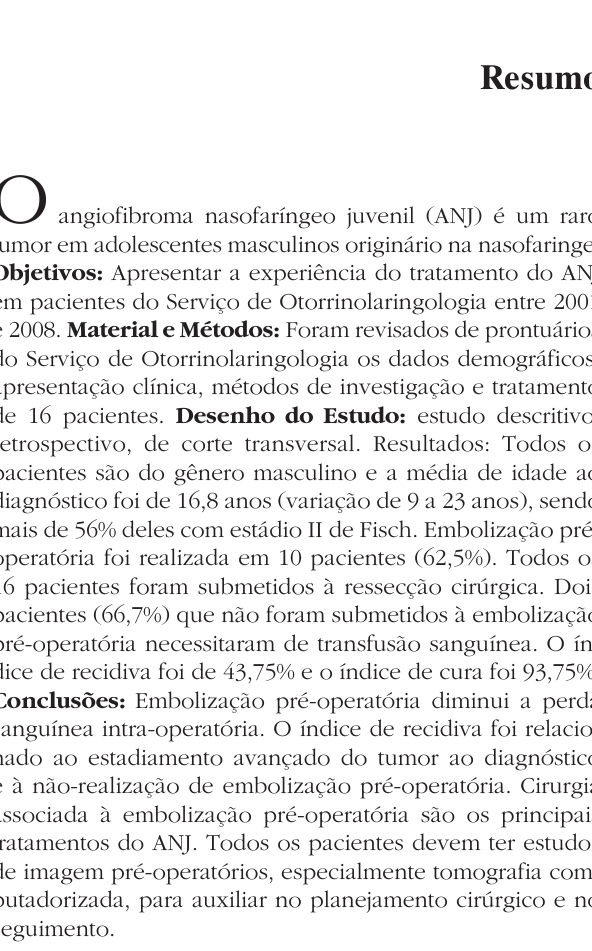
O angiofibroma nasofaríngeo juvenil (ANJ) é um raro tumor em adolescentes masculinos originário na